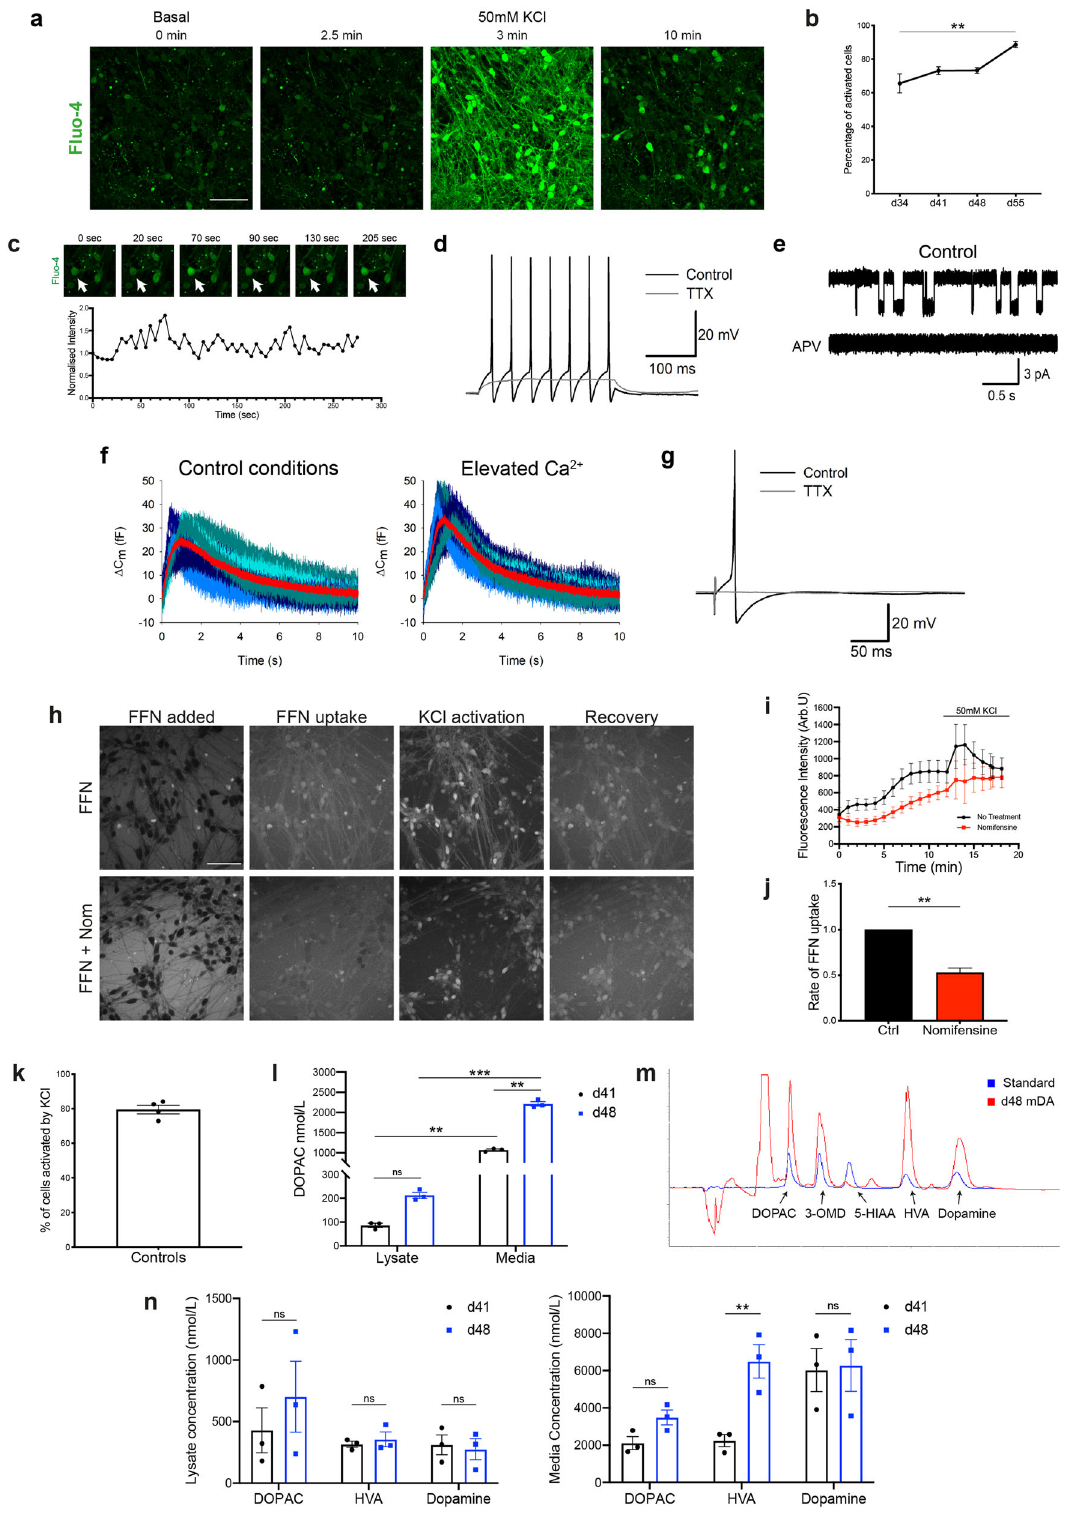
increased ROS production together with depleted antioxidant levels suggests that both A53T and SNCA x3 mDA neurons exhibit oxidative stress as a late phenotype. We measured the lysosomal compartment in SNCA -PD neurons using LysoTracker Deep red; a cationic fl uorescent dye that